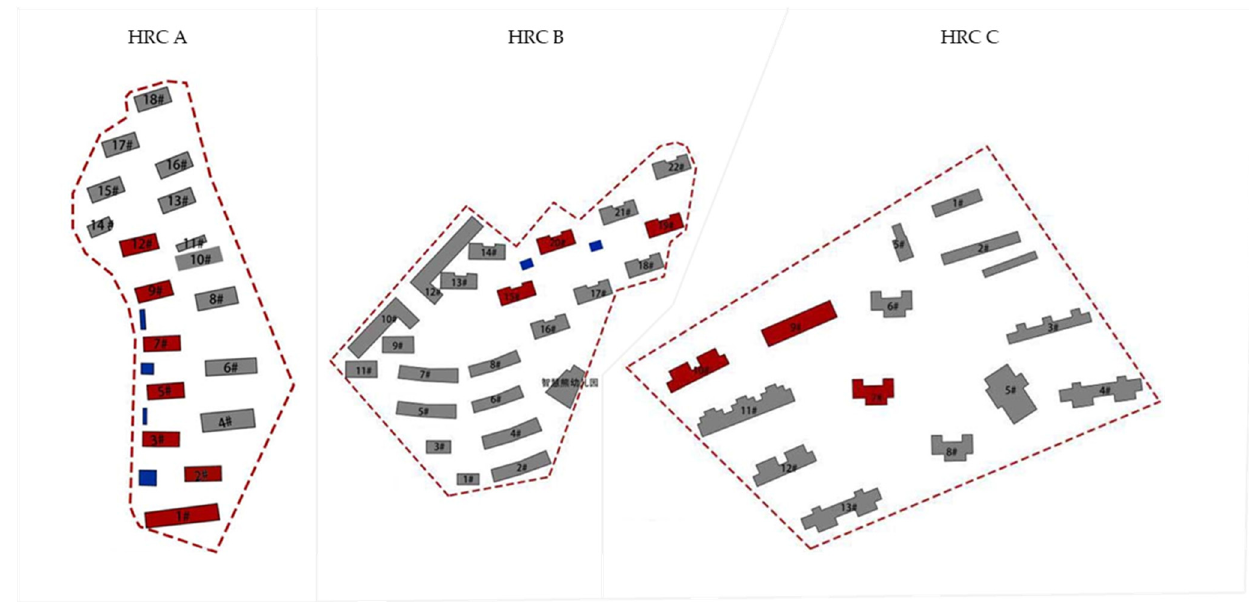
Figure 16. The optimized layout of HRC A ( left ), B ( middle ), and C ( right ).